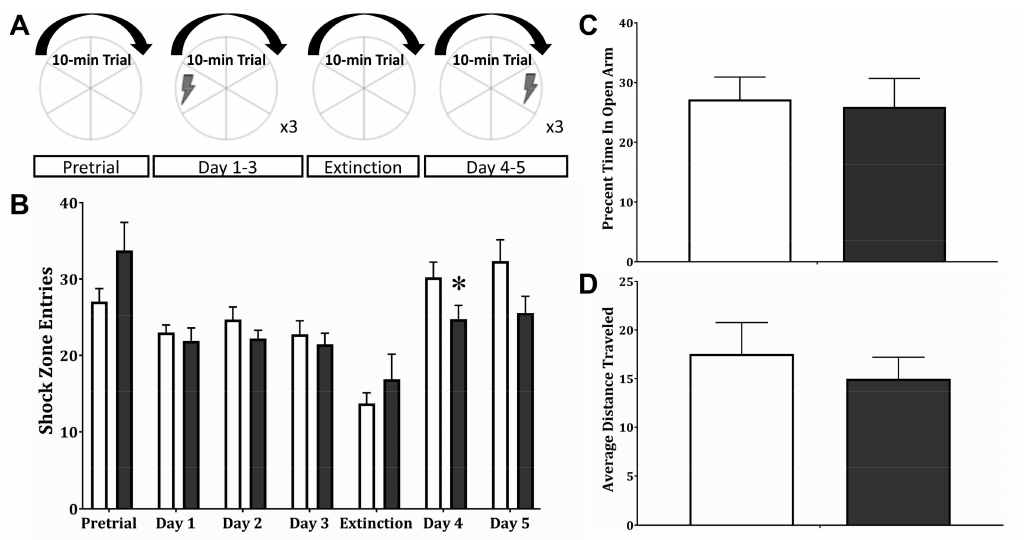
Figure 4. Active avoidance initially shows altered cognitive flexibility in adult SNAP-25b-deficient mice of both sexes with no di ff erence in anxiety-like behaviors or locomotion. ( A ): Active